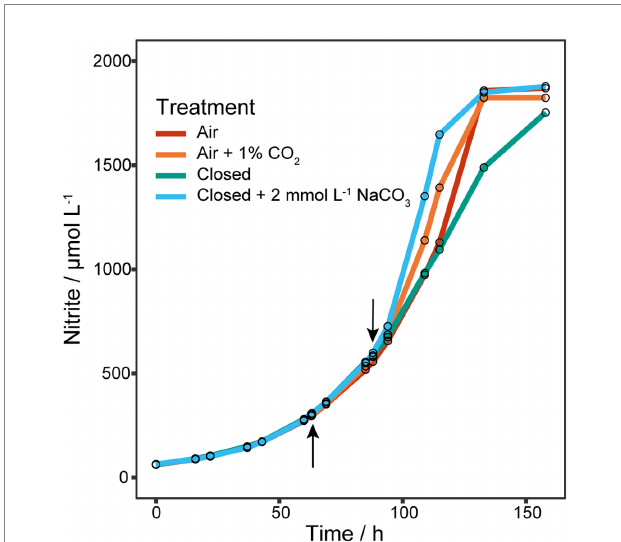
FIGURE 1 Effect of NO-donor and CO 2 on μ . Four 1.5 L batch cultures grown in 2 L bioreactors gassed with 2 sL L − 1 h − 1 air ( n = 1). The upward arrow indicates the addition of different amounts of the NO-donor 2,2 ′ -(2-Hydroxy-2-nitrosohydrazinylidene)bis-ethanamine (DETA NONOate) to early exponential cultures, after which gassing was stopped and reactors clamped off to prevent gas exchange. As no effect on the nitrite production was observed, cultures were tested for CO 2 limitation indicated by the downward arrow. One culture was gassed again with air, one with air plus 1% CO 2 , one was kept closed and one was kept closed but with the addition of 2 mmol L − 1 NaHCO 3 . Addition of CO 2 to the in-gas or NaHCO 3 to the culture medium increased μ , while gassing with air or keeping the reactor closed did not change or reduce μ ,